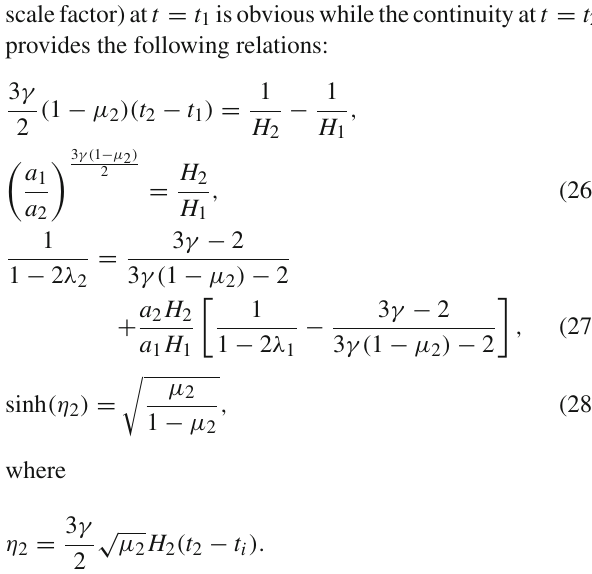
where t i is the constant of integration. Here (λ 1 , a 1 , H 1 ) and (λ 2 , a 2 , H 2 ) are the values of parameter λ , scale factor and Hubble parameter respectively at the transition points t = t 1 and t = t 2 . It will be now examined whether this cosmic evolution across these three phases is continuous or not. Then continu- ity of the deceleration parameter at the transition time t = t 1 and t = t 2 , gives μ = μ . 1 2 Continuity of physical parameters (i.e Hubble parameter, scale factor) at t = t 1 is obvious while the continuity at t = t